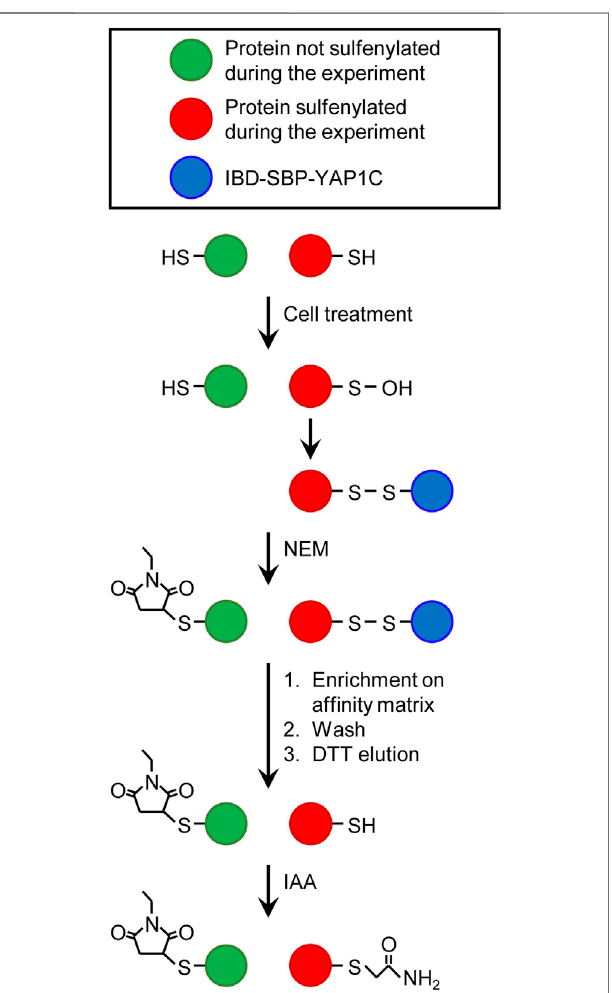
FIGURE 13 | Differential alkylation of cysteine thiols and sulfenic acids. Aftercelltreatment,freethiolsareimmediatelyblockedwithN-ethylmaleimide (NEM). Proteins containing at least one sulfenylated cysteine that forms a disul fi de bridge with IBD-SBP-YAP1C are enriched on the streptavidin af fi nity matrix, extensively washed, eluted with dithiothreitol (DTT), and alkylated with iodoacetamide (IAA). This results in a differential alkylation of originally reduced or sulfenylated cysteines within the af fi nity-puri fi ed proteins. For more details about the experimental procedure, see Materials and